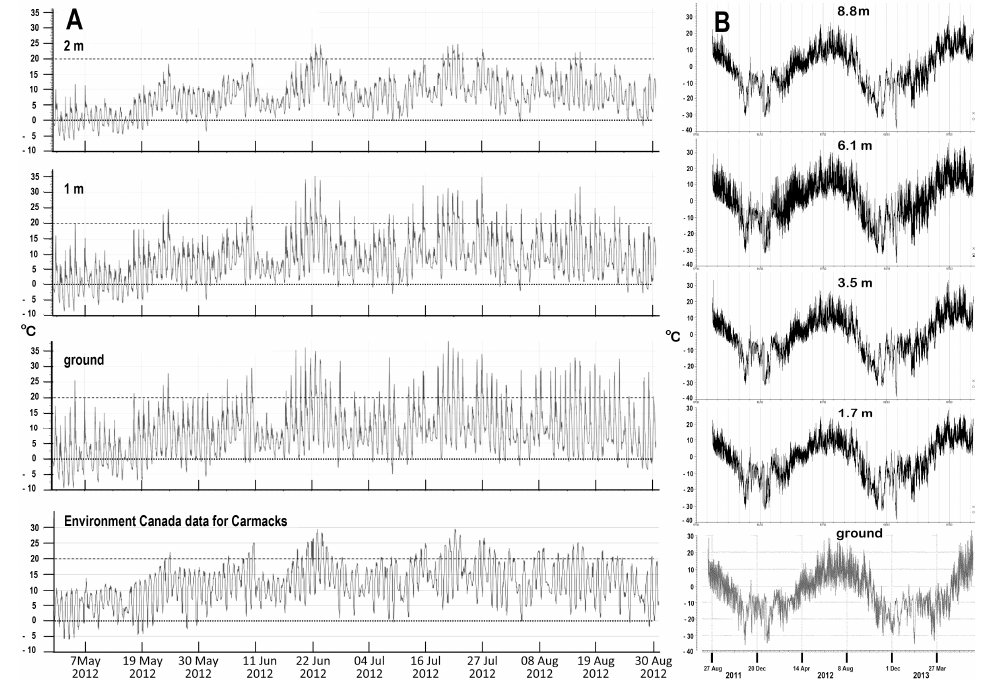
Figure 5. Temperature data for several trunk heights at one location on the East Fork site. ( A ) Growing season temperatures at ground level and one and two metres above, compared with official data recorded at Carmacks, during the summer of 2012. ( B ) Air temperature fluctuations during calendar years 2011–2013 at ground level and four heights above. The slightly warmer ground temperatures during winter are presumably due to snow cover.